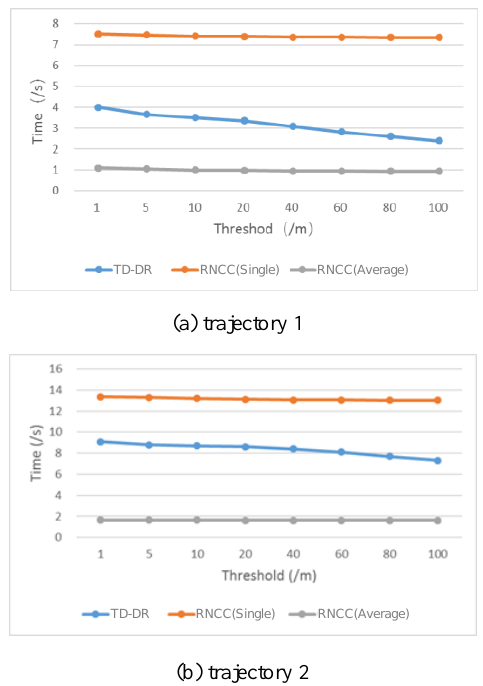
Figure 6. Efficiency comparison